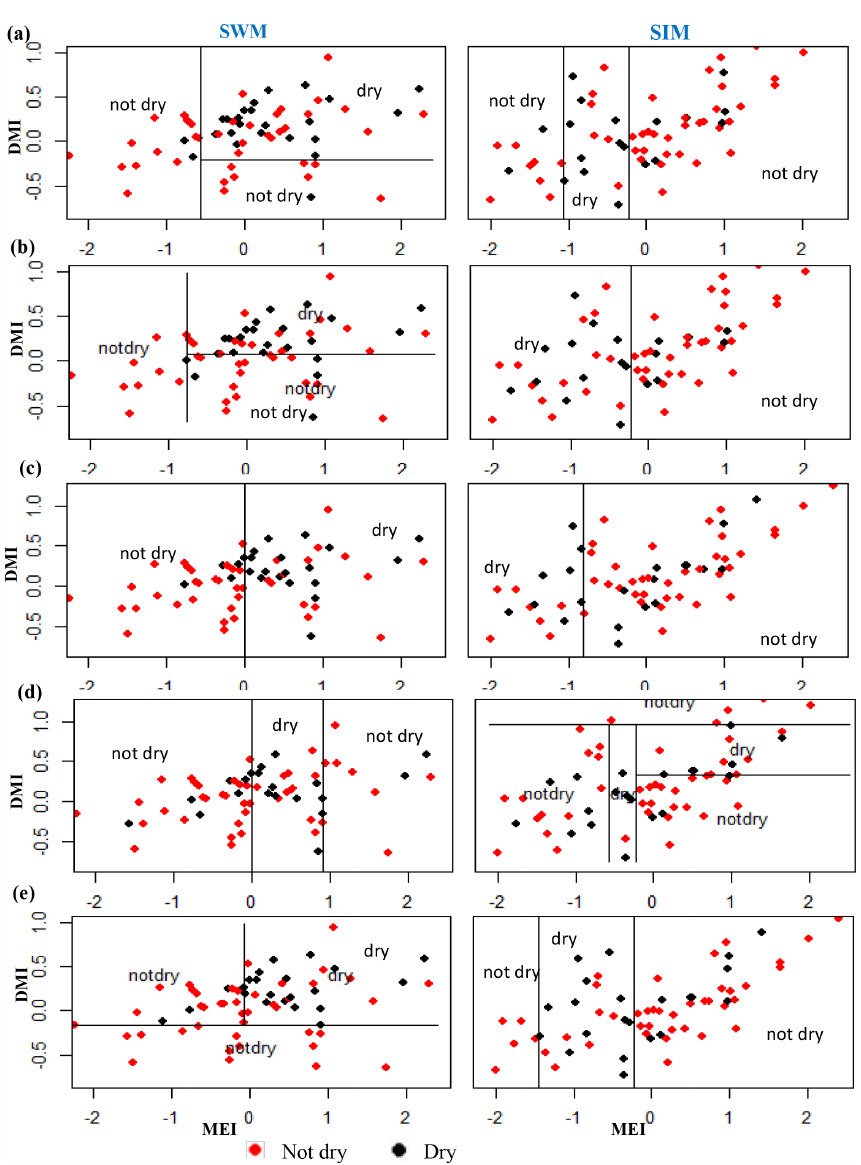
Figure A8. Identifying relationships between two rainfall classes (dry, not dry) and MEI and DMI values using classification tree models for dry and intermediate zone subbasins for the NEM and SIM seasons. (f) Randenigala, (g) Bowatenna, and (h)